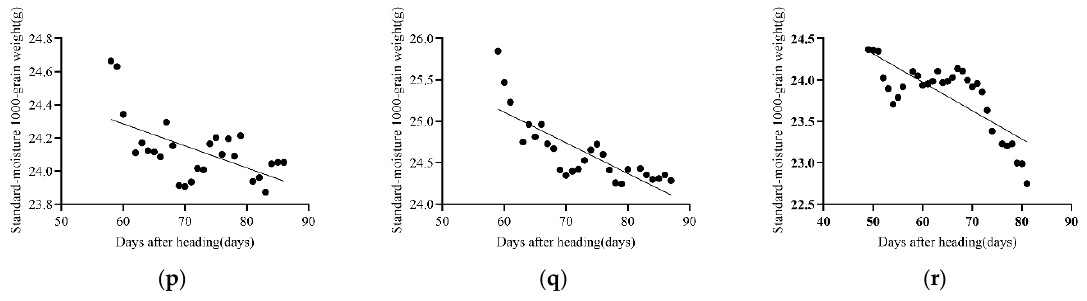
Figure 3. Linear regression curve of the standard-moisture 1000-grain weight in 2020:( a – r ) means 18 rice varieties in 2020’s experiment, ( a ) Jijing 816; ( b ) Wuyoudao 4; ( c ) Longyang 16; ( d ) Songjing 29;